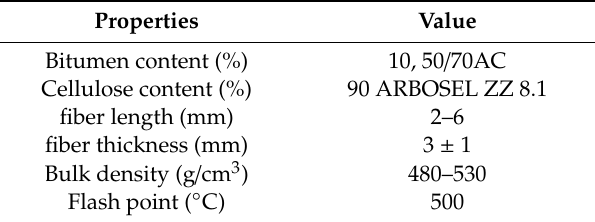
Table 4. The Properties of Viatop premium.